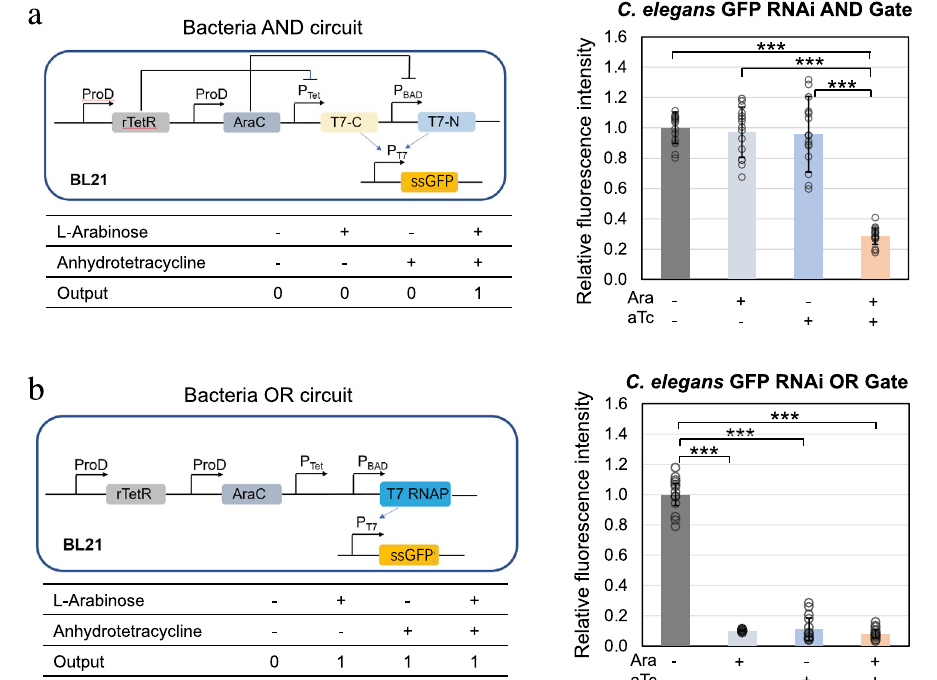
Fig. 3 GFP expression in C. elegans programmed by AND and OR gates. Single-stranded 200-bp gfp RNA synthesis in E. coli BL21, controlled by a AND gate or b OR gate, interferes with GFP expression in C. elegans that have ingested the bacteria. (*** P < 0.001 using two-sided t -test with Bonferroni correction. Error bars represent the mean ± standard deviation for n = 15 worms over three independent experiments) Source data are available in the Source Data fi